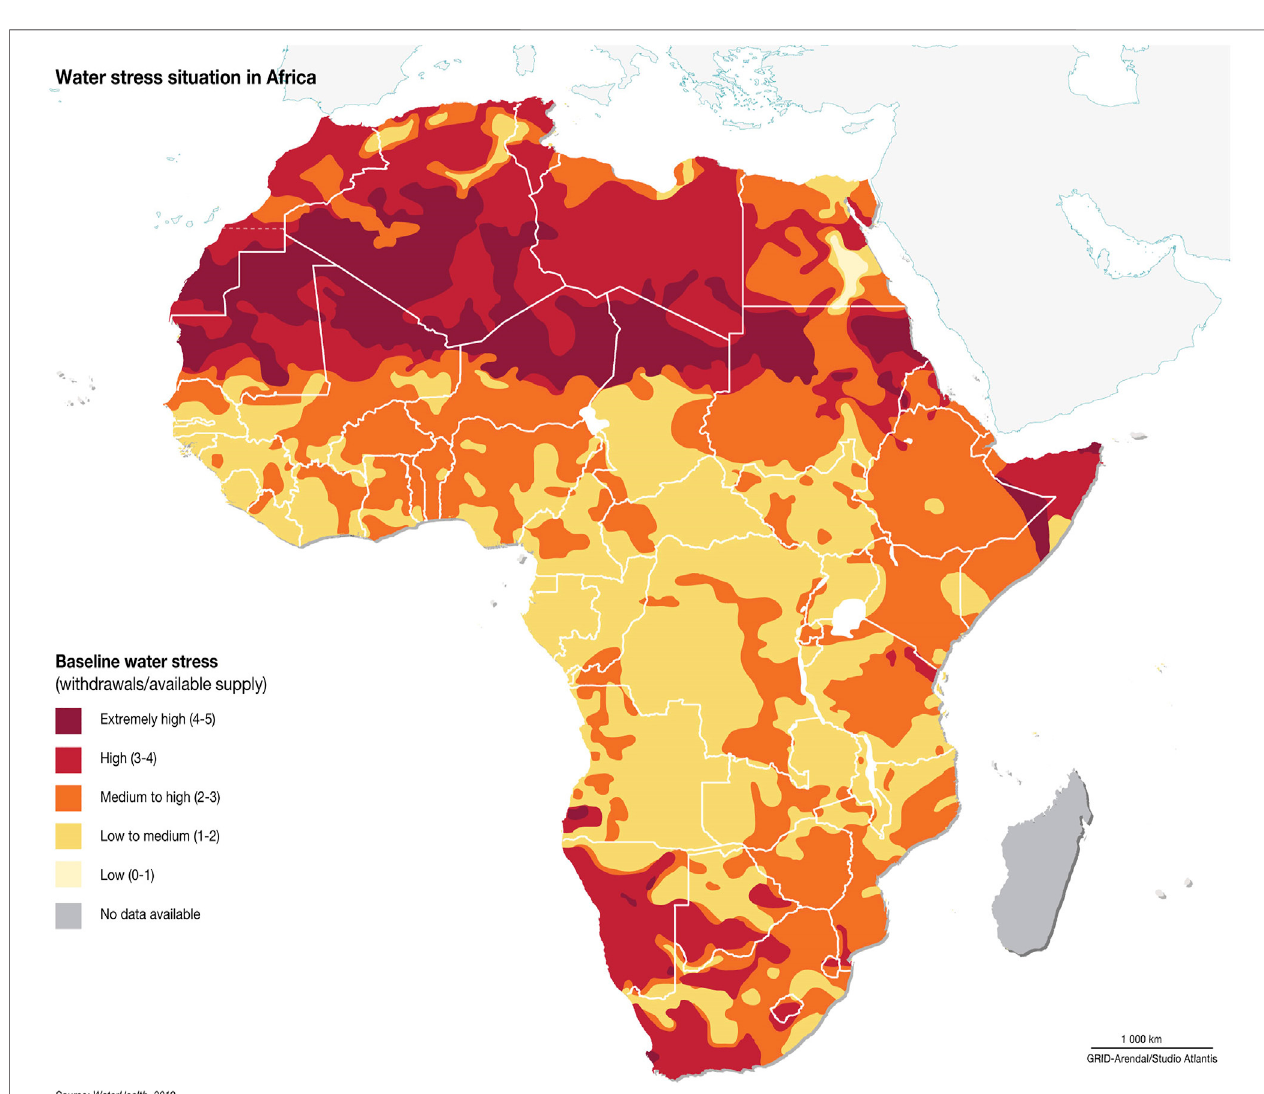
FIGURE 1 | Water stress situation in